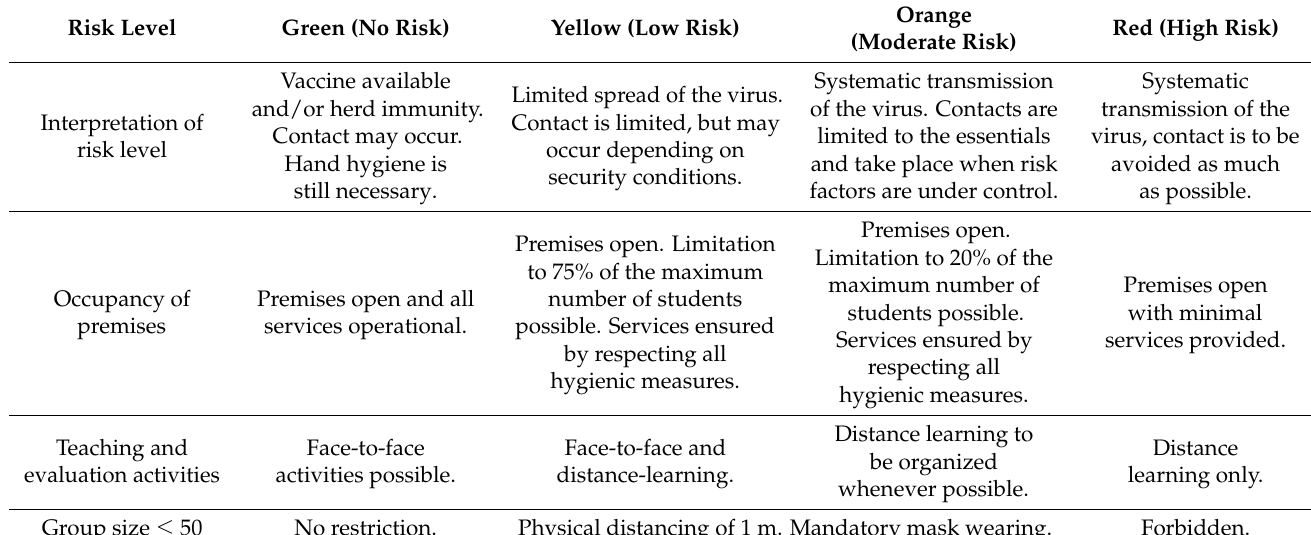
Table A1. Color codes in universities depending on the risk level associated with